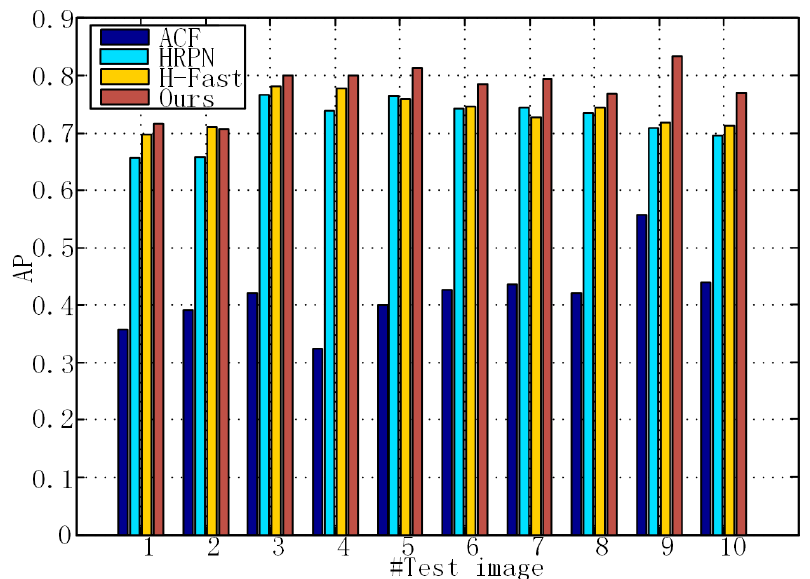
Figure 8. Performance comparisons of the proposed method, HRPN, H-Faster (HRPN + Fast R-CNN) and aggregated channel features (ACF) detector in terms of mAP values in 10 test images.